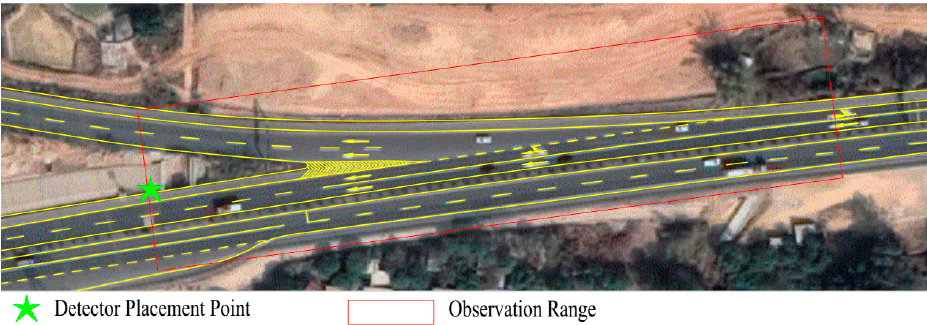
Figure 2. The installation point and observation area of the microwave detector.